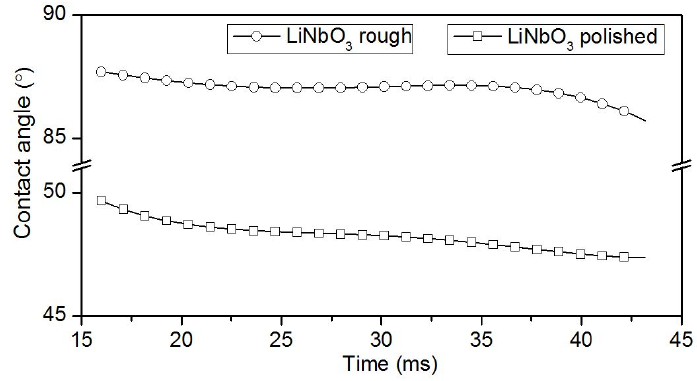
Figure 6. Time dependences of the contact wetting angle of Ag nano-ink deposited on a rough or polished surface of LiNbO 3 sample during surface wetting.